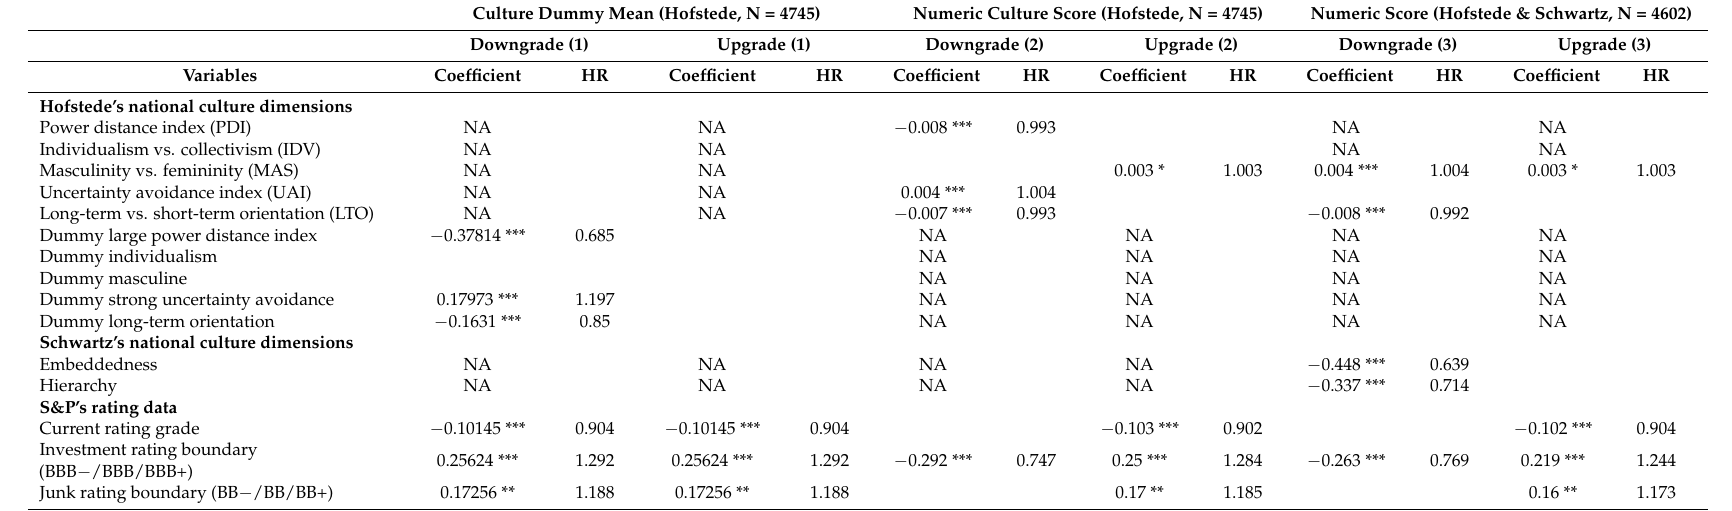
Table 5. Cox’s regression models for rating changes of non-U.S.